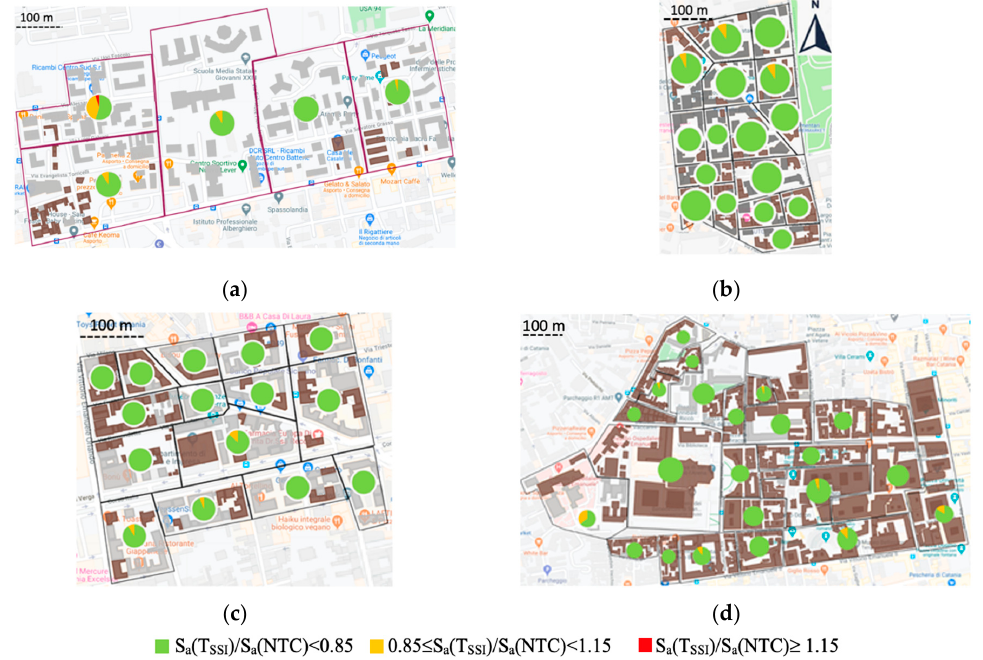
Figure 21. Spatial distribution of S a ( T SSI ) / S a ( NTC2018 ) ratios for the 1990 seismic input: ( a ) west area; ( b ) northeast area; ( c ) north Old Town; ( d ) south Old Town.